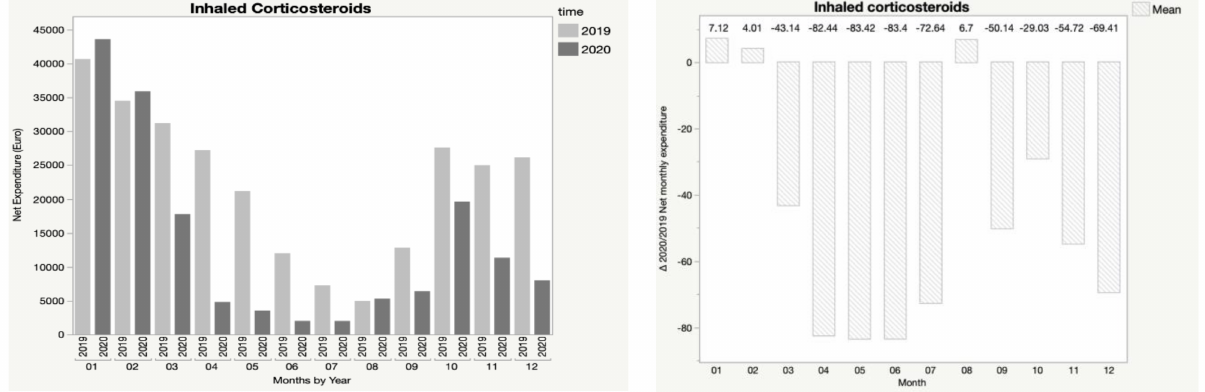
Figure 5. Trend in net expenditure (EUR) and delta 2020/2019 of net monthly expenditure of inhaled corticosteroids, from January through December of the years 2019 and 2020, in the study population of 35,787 children aged 0–14